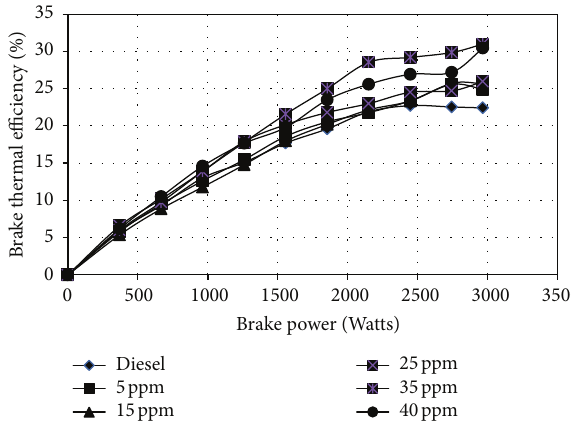
Figure 7: Variation of kinematic viscosity of diesel as a function of temperature.